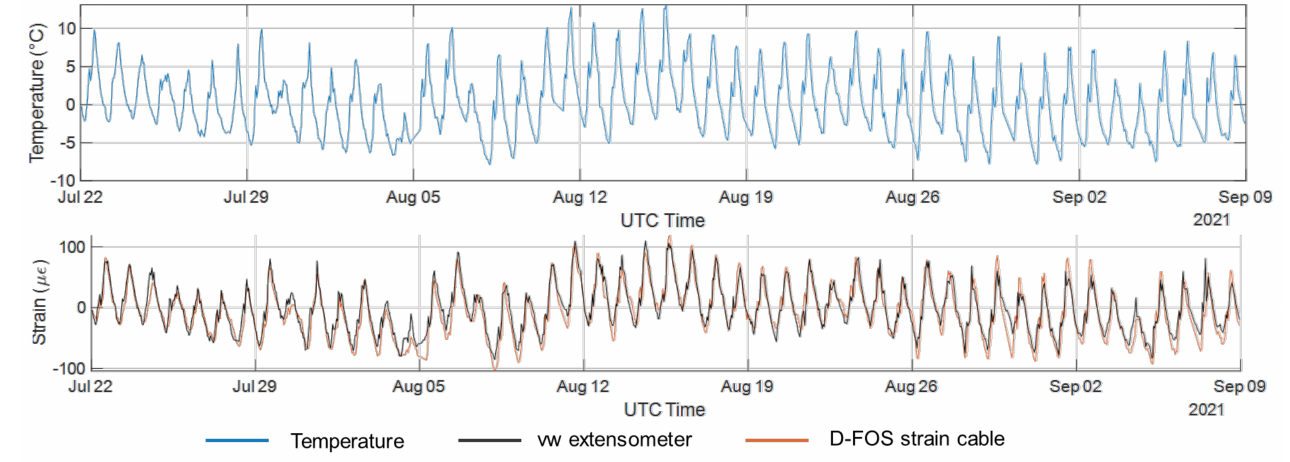
Figure 12. Comparison of the strain profile obtained respectively by the VW extensometer and the D-FOS strain cable at position A1 (form 22 July 2021 to 9 September 2021). On the upper part is also reported the temperature variation profile at the same